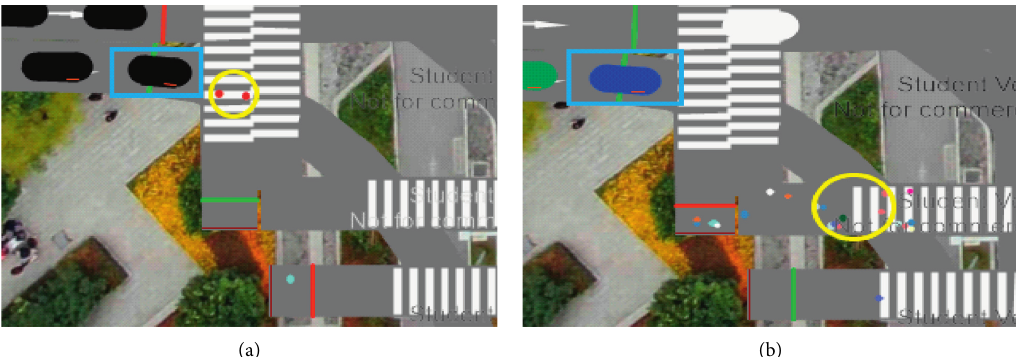
Figure 1: Timing of existing signal lights at the intersection.